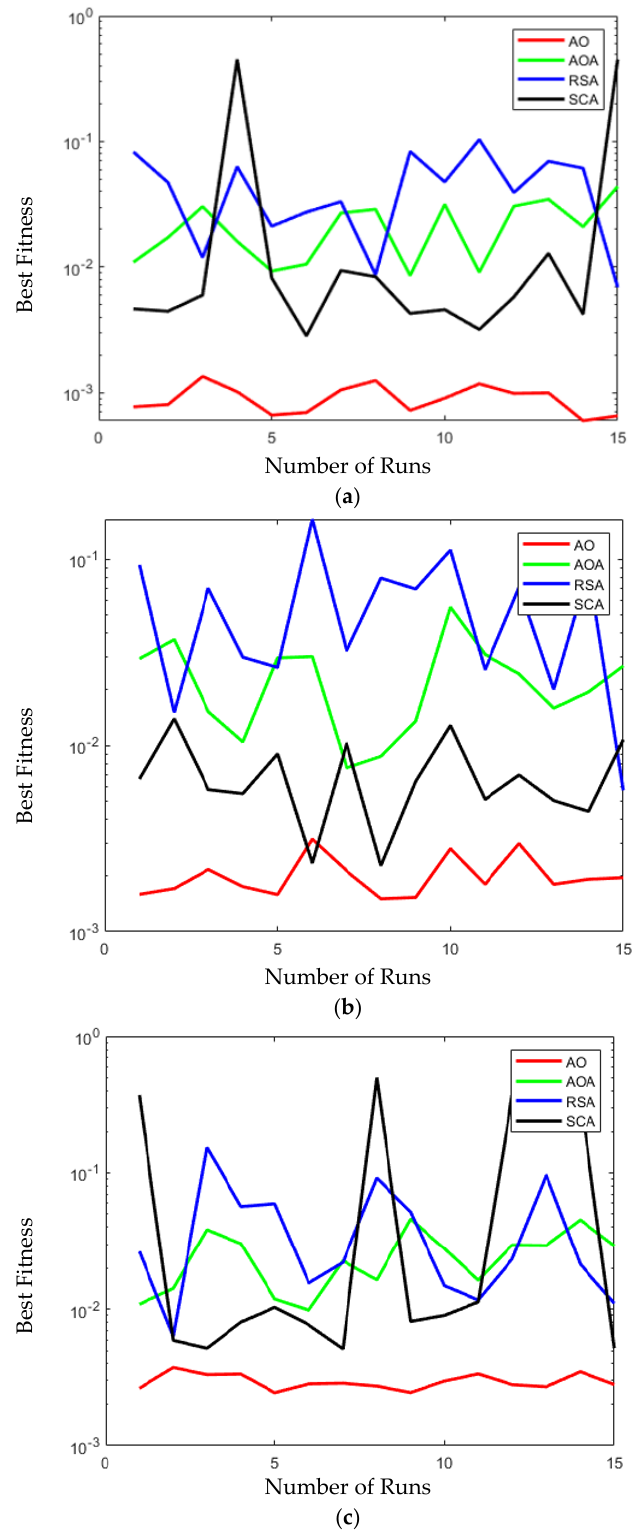
Figure 7. Statistical analyses plots of AO, AOA, SCA, and RSA for Np = 50, T = 2000. ( a ) Noise level = 0.04. ( b ) Noise level = 0.06. ( c ) Noise level = 0.08. To further investigate the performance of AO vs. RSA, AO vs. AOA, and AO vs. SCA, a nonparametric Mann-Whitney U test [47] is performed on average fit values for